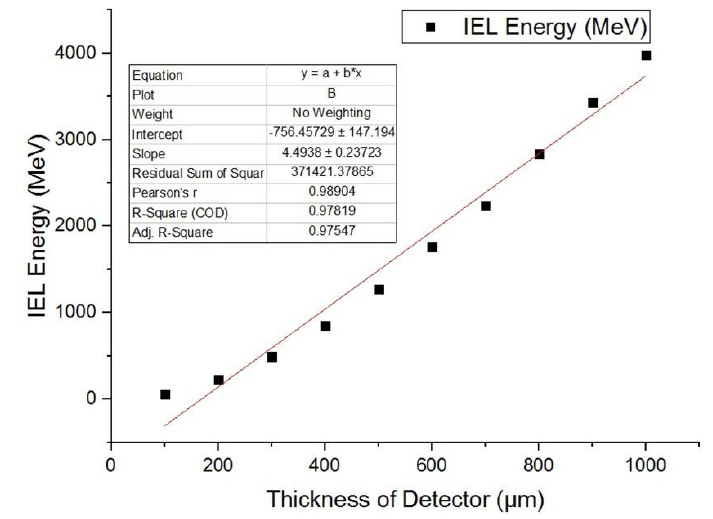
Figure 19. Relationship between IEL produced by gammas and the thickness of SDD.